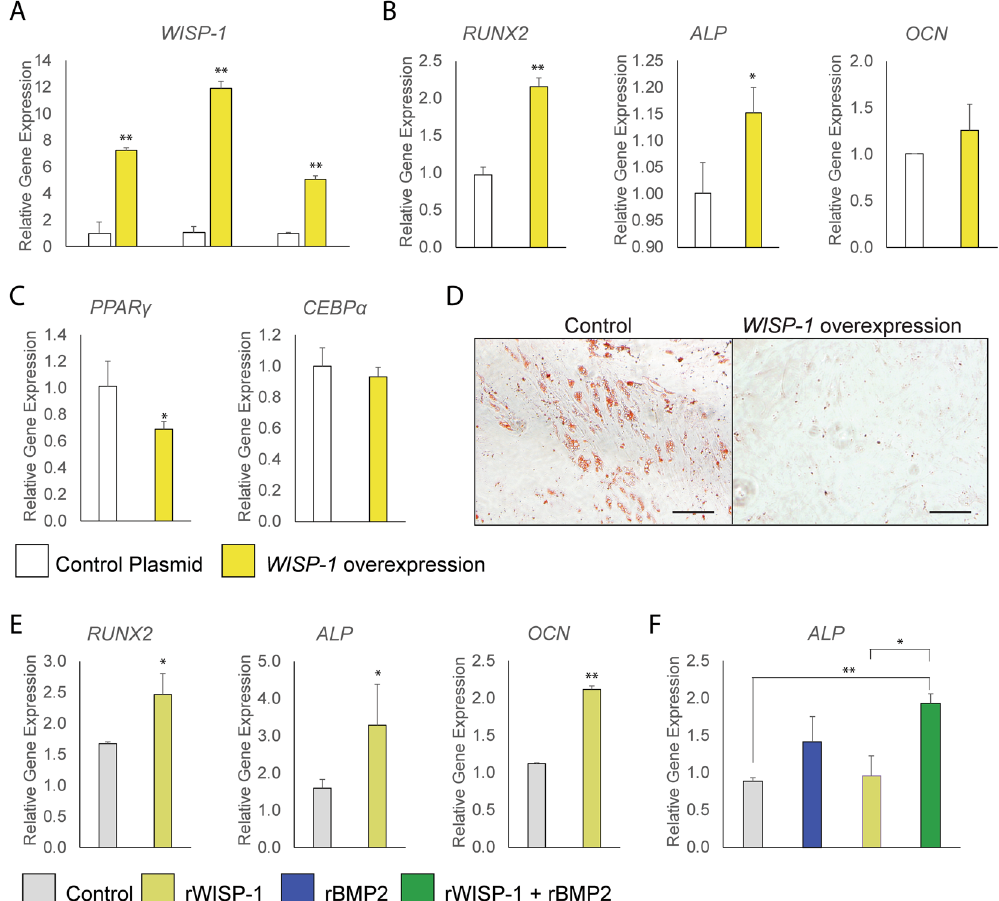
Figure 4. Osteogenic and adipogenic differentiation of human PSC with WISP-1 overexpression or rWISP-1 protein. ( A – D ) WISP-1 overexpression or control plasmid treated PSC were evaluated for osteogenic and adipogenic differentiation. ( A ) Efficacy of WISP-1 plasmid in human PSC, assessed by qRT-PCR at 6, 9, and 15 days. ( B ) Expression levels of osteogenic gene markers by qRT-PCR at 3 days of osteogenic differentiation, including RUNX2 (Runt-related transcription factor 2), ALP (Alkaline Phosphatase), COL1A1 (Type I Collagen) , and OCN ( Osteocalcin ). ( C ) Adipocytic gene markers assessed by quantitative RT-PCR at 3 days of differentiation, including PPAR γ ( Peroxisome proliferator-activated receptor gamma ), CEBP α ( CCAAT/ enhancer-binding protein alpha ). ( D ) Oil red O staining of human PSC with or without WISP-1 overexpression, 15 days of differentiation. ( E , F ) Osteogenic differentiation of human PSC with or without recombinant (r) WISP-1 protein (200 ng/mL). ( E ) Expression levels of osteogenic gene markers by qRT-PCR at 3 days of osteogenic differentiation, including RUNX2 , ALP , and OCN . ( F ) Effects of rWISP-1 (200 ng/mL) and rBMP2 (50 ng/mL) combined application in human PSC. Expression levels of ALP assessed by qRT-PCR at 3 days of osteogenic differentiation. * P < 0.05; ** P < 0.01. Scale bars: 100 µ